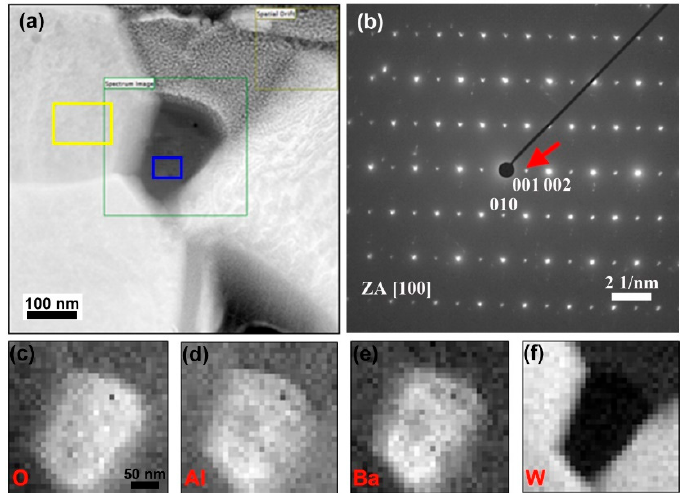
Figure 3. Structural and elemental analysis of a Ba–Al–O particle at the cathode surface. ( a ) HAADF image, with green square showing the area for EELS mapping, as well as blue and yellow boxes showing sites for EDS analysis of the Ba–Al–O particle and neighboring W grain, respectively; ( b ) selected area diffraction pattern acquired from the Ba–Al–O particle; ( c – f ) EELS elemental maps of O, Al, Ba and W; these four maps share the same scale bar.